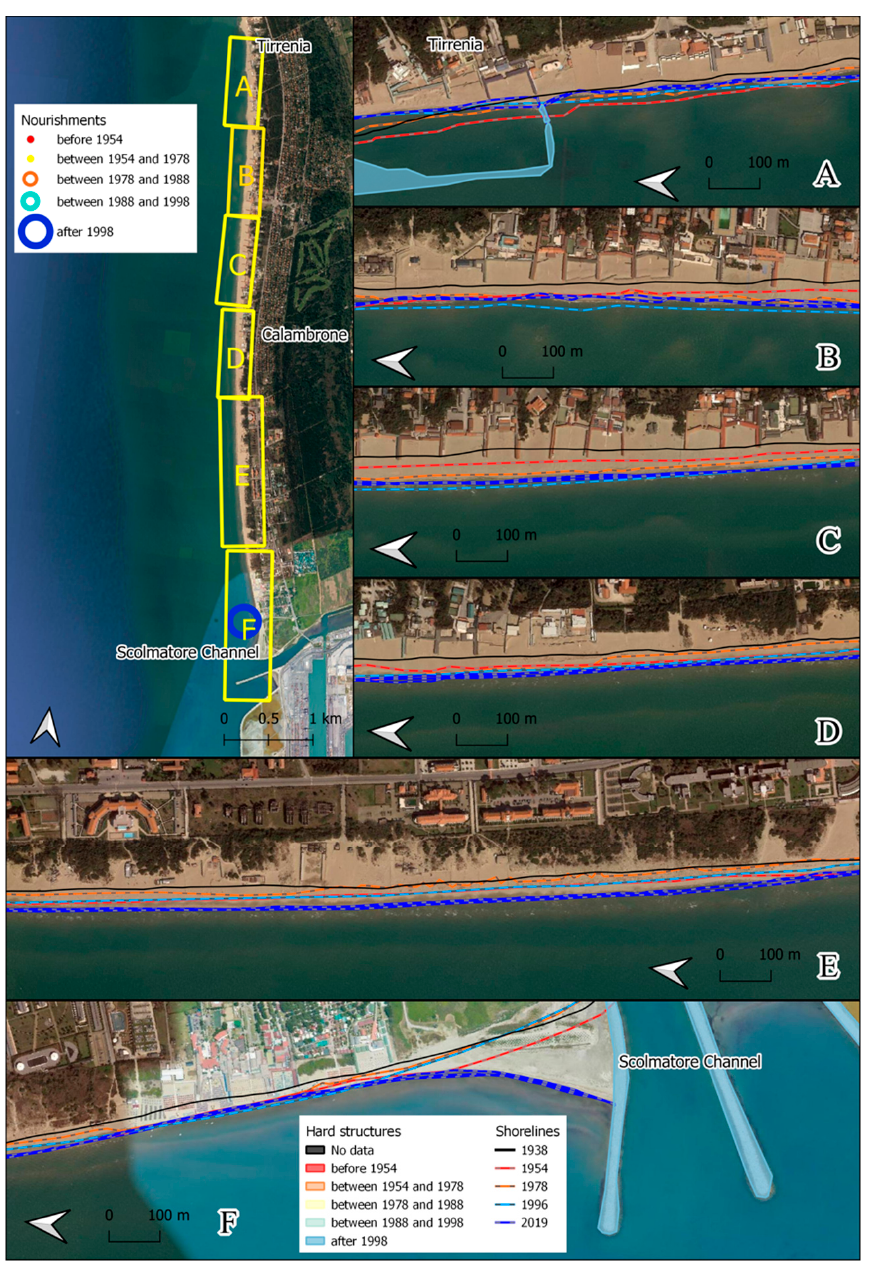
Figure 9. Identification of hard and soft operations along the sector comprised between Tirrenia and the Scolmatore Channel mouth. Polygons represent the hard structures; dots represent the nourishments. The yellow frames in the top left panel correspond to the zoom in panels to the right and at the bottom. The background image has been retrieved from the Google Earth data-base.